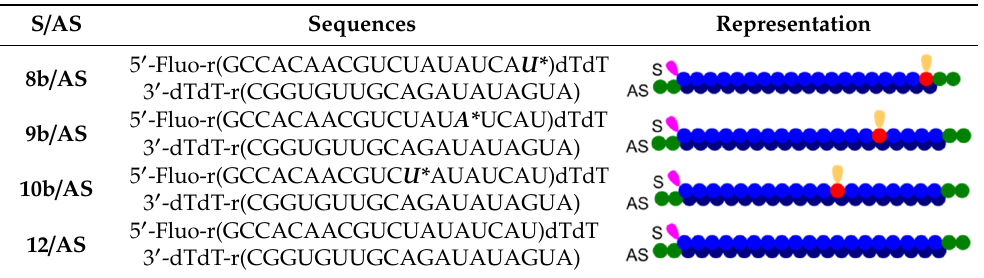
Figure 5. Modified siRNAs: ( A ) Overlay of the circular dichroism (CD) spectra of the modified siRNAs